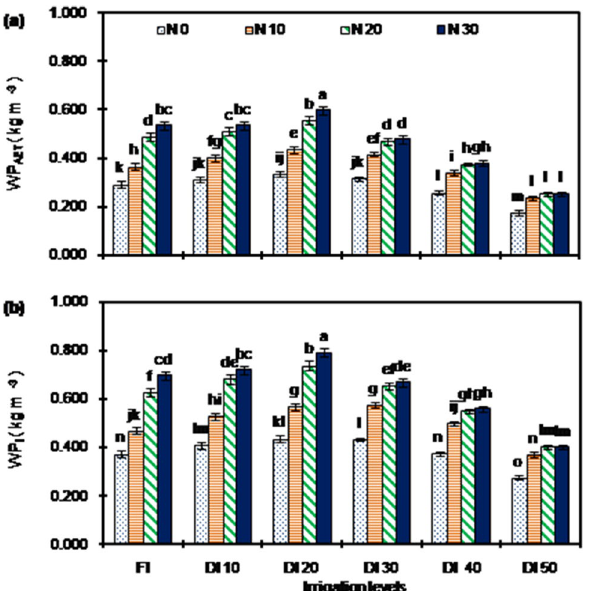
Figure 3. ( a ) WP AET and ( b ) WP I of peanut under different irrigation and nitrogen application rate treatments [Data points are mean ± standard error, n = 9 (3 × 3; 3 years, 3 replications)]. Bars are standard error. Bars having different letter/s are significantly different at P < 0.05 level according to LSD. AET : actual evapotranspiration;